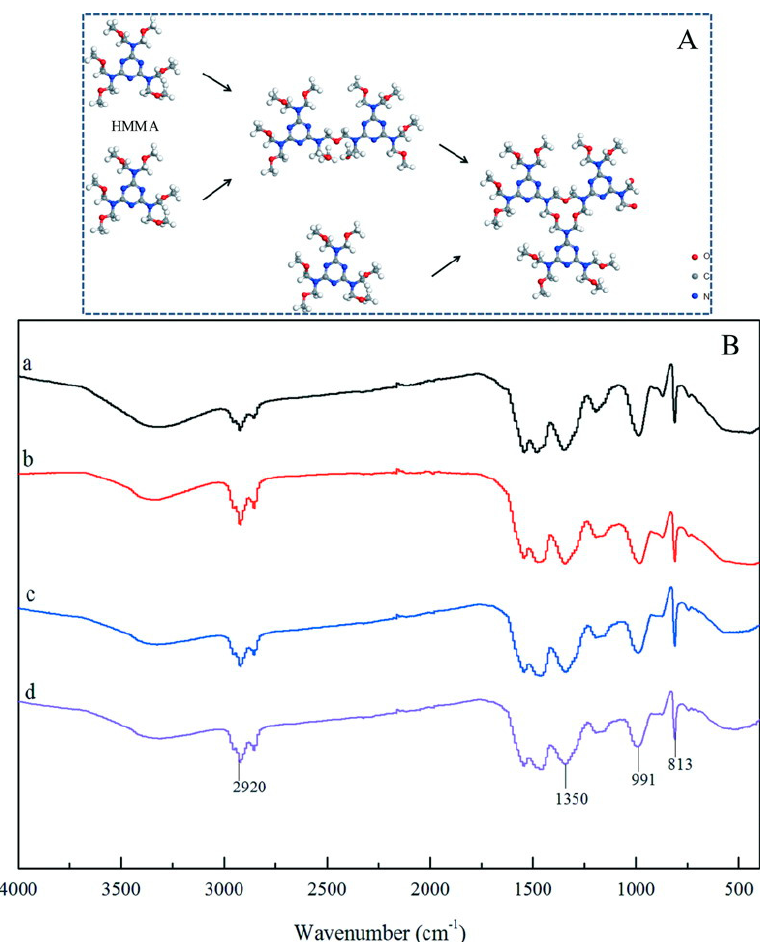
Figure 8. Chemical structures of microcapsule shells fabricated under various pH values, ( A ) molecule structure of HMMM cross-linkage process, ( B ) the FTIR curves of the microcapsule samples prepared under various pH values: ( a ) M-3, ( b ) M-4, ( c ) M-5, and ( d ) M-6.